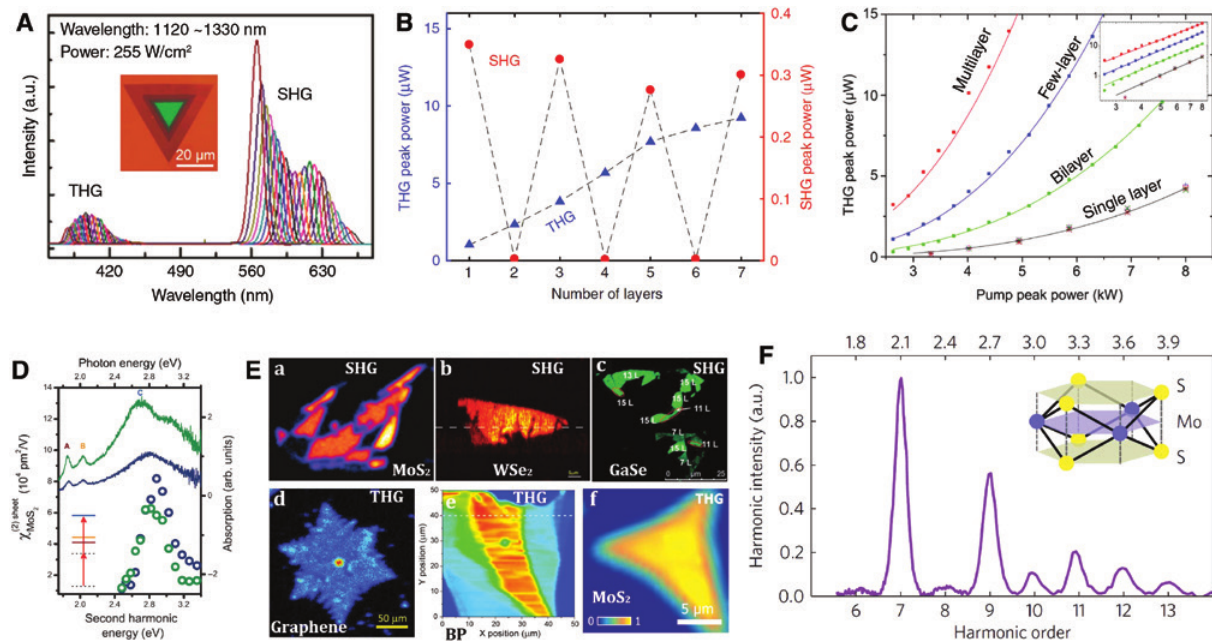
Figure 11: HG and imaging of 2DLMs. (A) Large spectral range (1120–1330 nm) SHG and THG emission from spiral WS nanosheets [208]. (B) Layer-dependent SHG and THG 2 emission from MoS [71]. (C) THG emission from various graphene layers as a function of pump power [63]. (D) Linear and SHG emission 2 spectra of monolayer (blue) and trilayer (green) MoS showing the resonance enhancement at exciton band. (A–C) Excitation bands 2